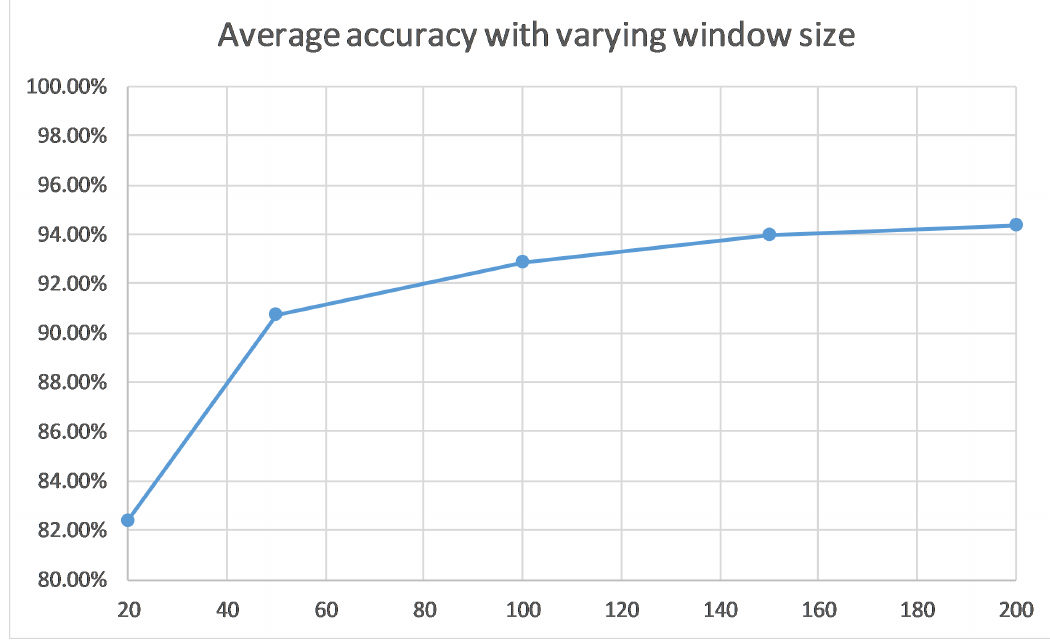
Figure 8. Average accuracy of the original train/test split of the WISDM dataset for varying window